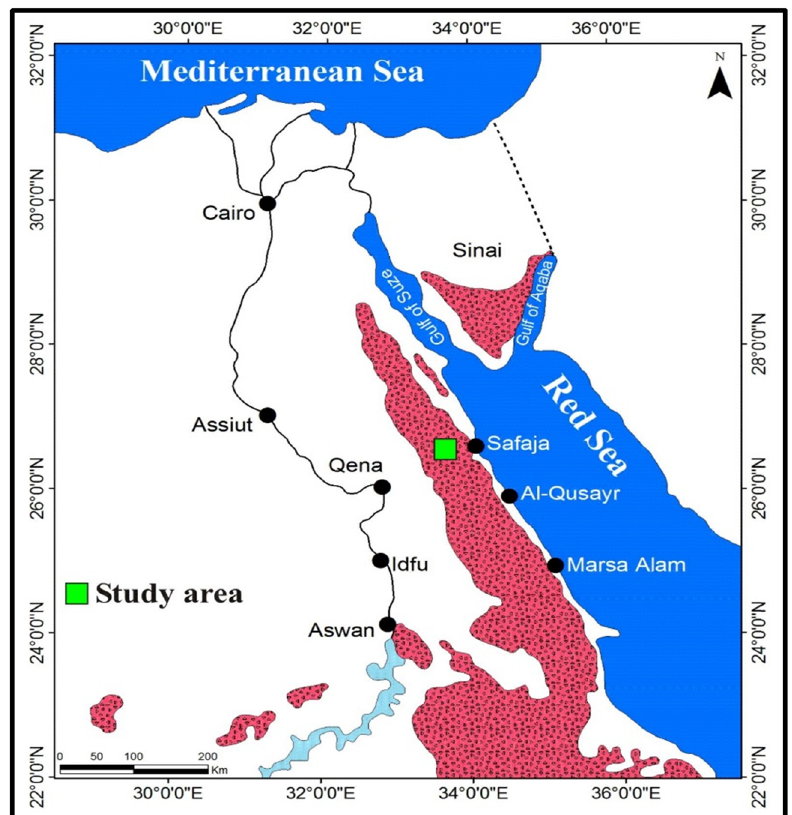
Figure 1: Sentinal - 2B 421 in RGB image showing the location of the study